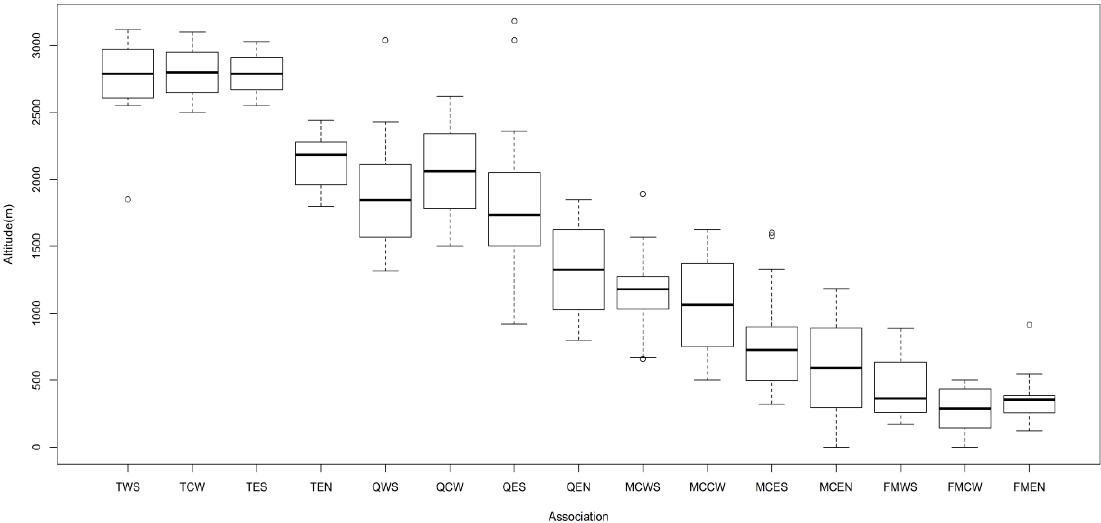
Figure 6. Distribution of different vegetation zones with different climatic regions in Taiwan. (TWS: Tsuga zone in southwestern climatic regions; TCW: Tsuga zone in central west climatic regions; TES: Tsuga zone in southeastern climatic regions; TEN: Tsuga zone in northeastern climatic regions; QWS: Quercus zone in southwestern climatic regions; QCW: Quercus zone in central west climatic regions;